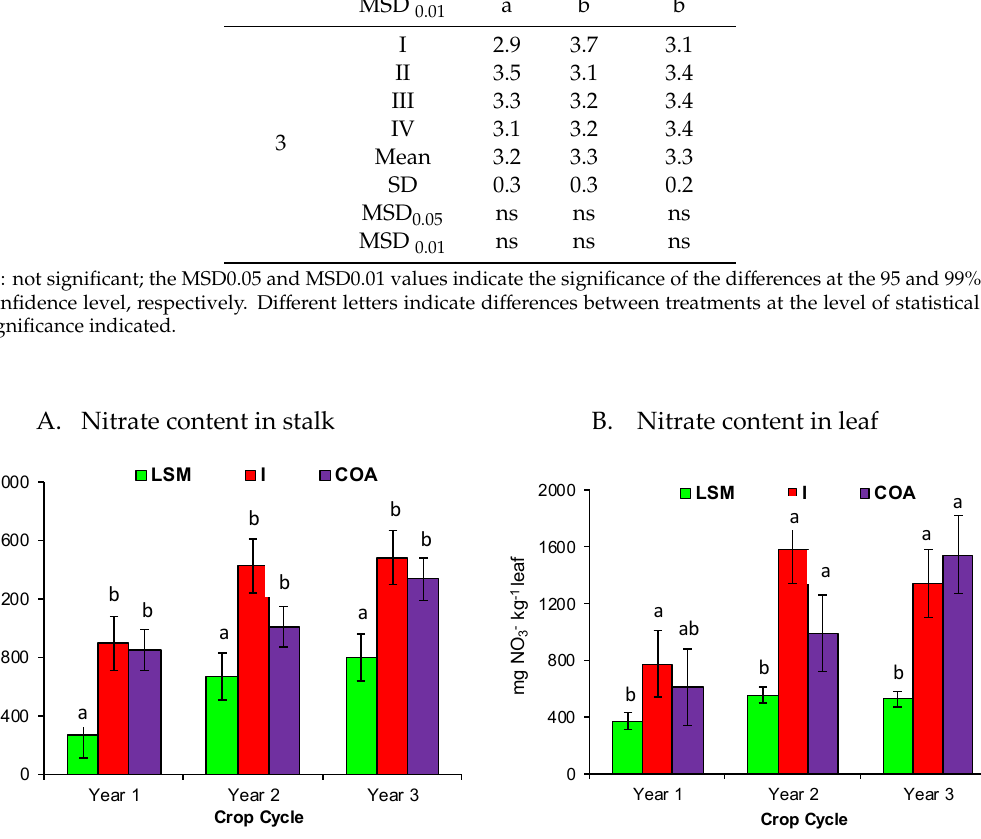
Figure4. ( A ).Thenitratecontentinthecelerystalkand( B ).Thenitratecontentintheceleryleaf, Figure 4. ( A ) . The nitrate content in the celery stalk and ( B ). The nitrate content in the celery leaf, according to the fertilization treatment: local sheep manure (LSM), inorganic treatment (I), and